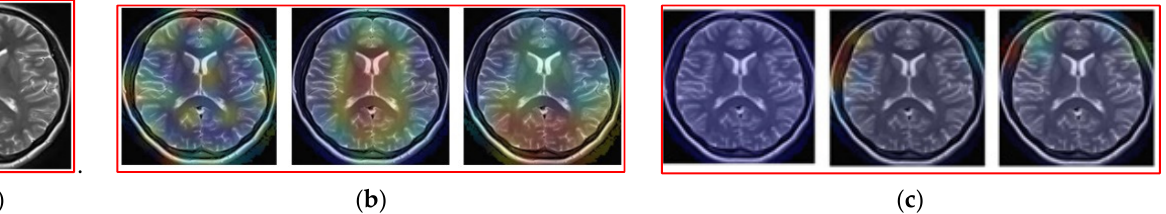
Figure 14. Examples of CAM images using MLP network: ( a ) Input image without tumor region, ( b ) CAM image at the last convolution layer of the DenseNet (Left), InceptionNet (Middle), and ResidualNet (Right) with respect to the non-tumor class; and ( c ) CAM images at the last convolution layer of the DenseNet (Left), InceptionNet (Middle), and ResidualNet (Right) with respect to the tumor class.